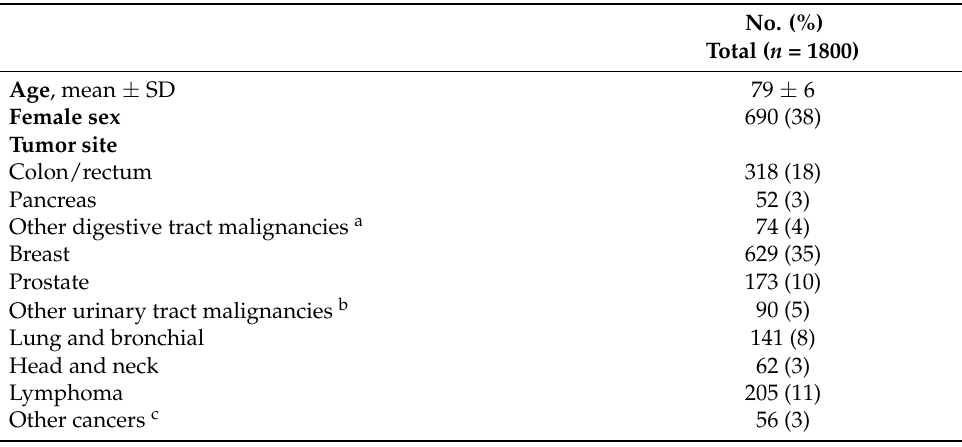
Table 1. Baseline characteristics of the study